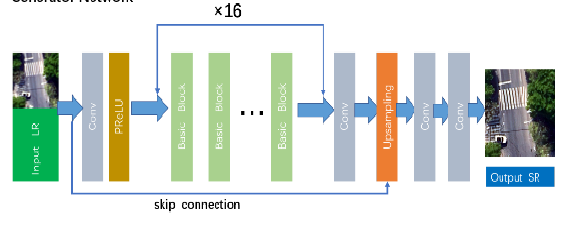
Figure 2 . Structure of Generator